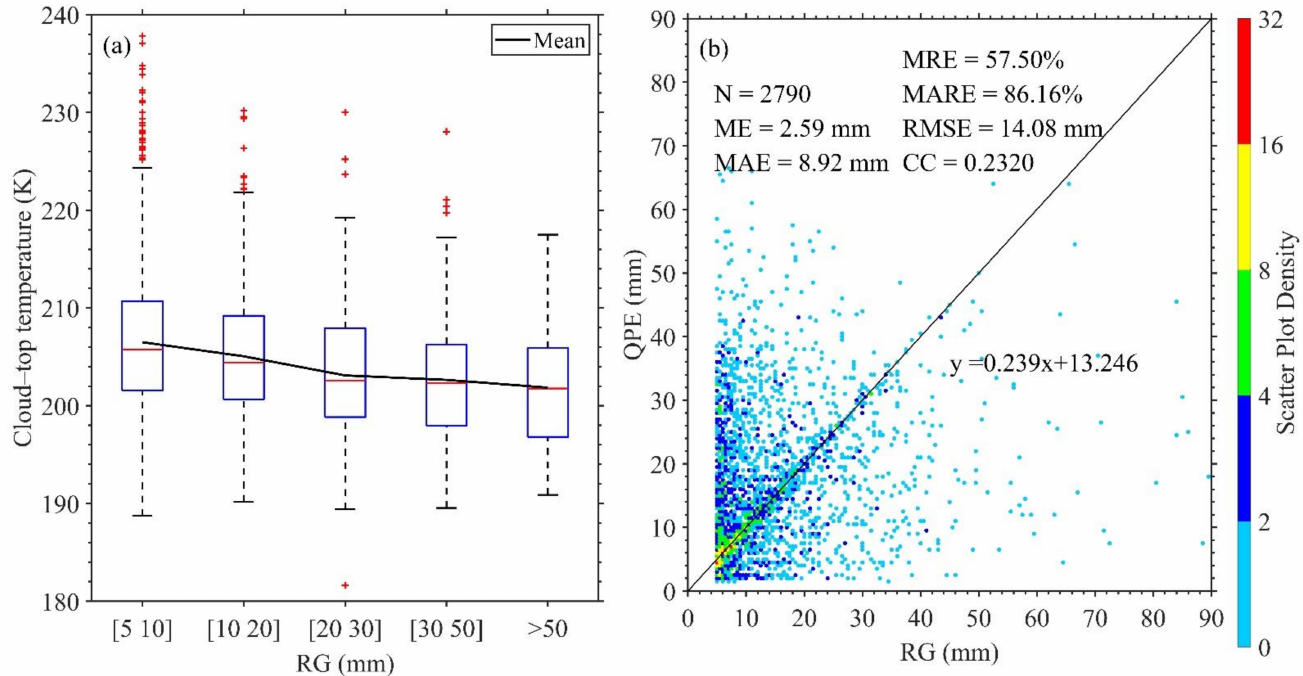
Figure 4. The plots of the RG hourly precipitation vs ( a ) the cloud-top temperature of LWIR channel 12 and ( b ) the primary FY-4A QPE from June to August of 2020 (In Figure 4a, bottom and top of boxes denote the 25th and 75th percentiles, with the horizontal lines inside the box being the median value; the dotted lines represent the range of the adjacent value, which is the most extreme value that is not an outlier; the outliers are marked by